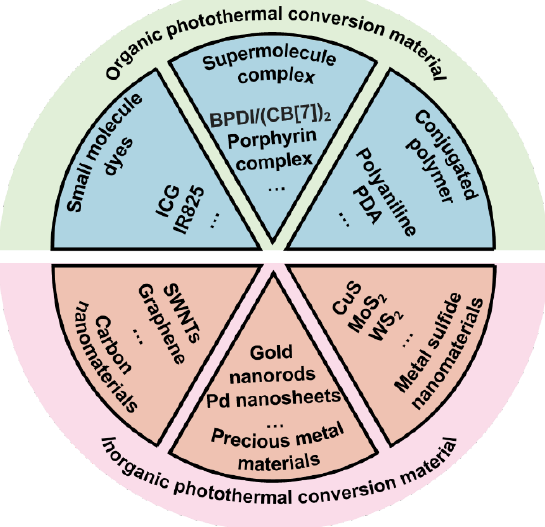
Figure 1. The classification of main photothermal conversion materials.